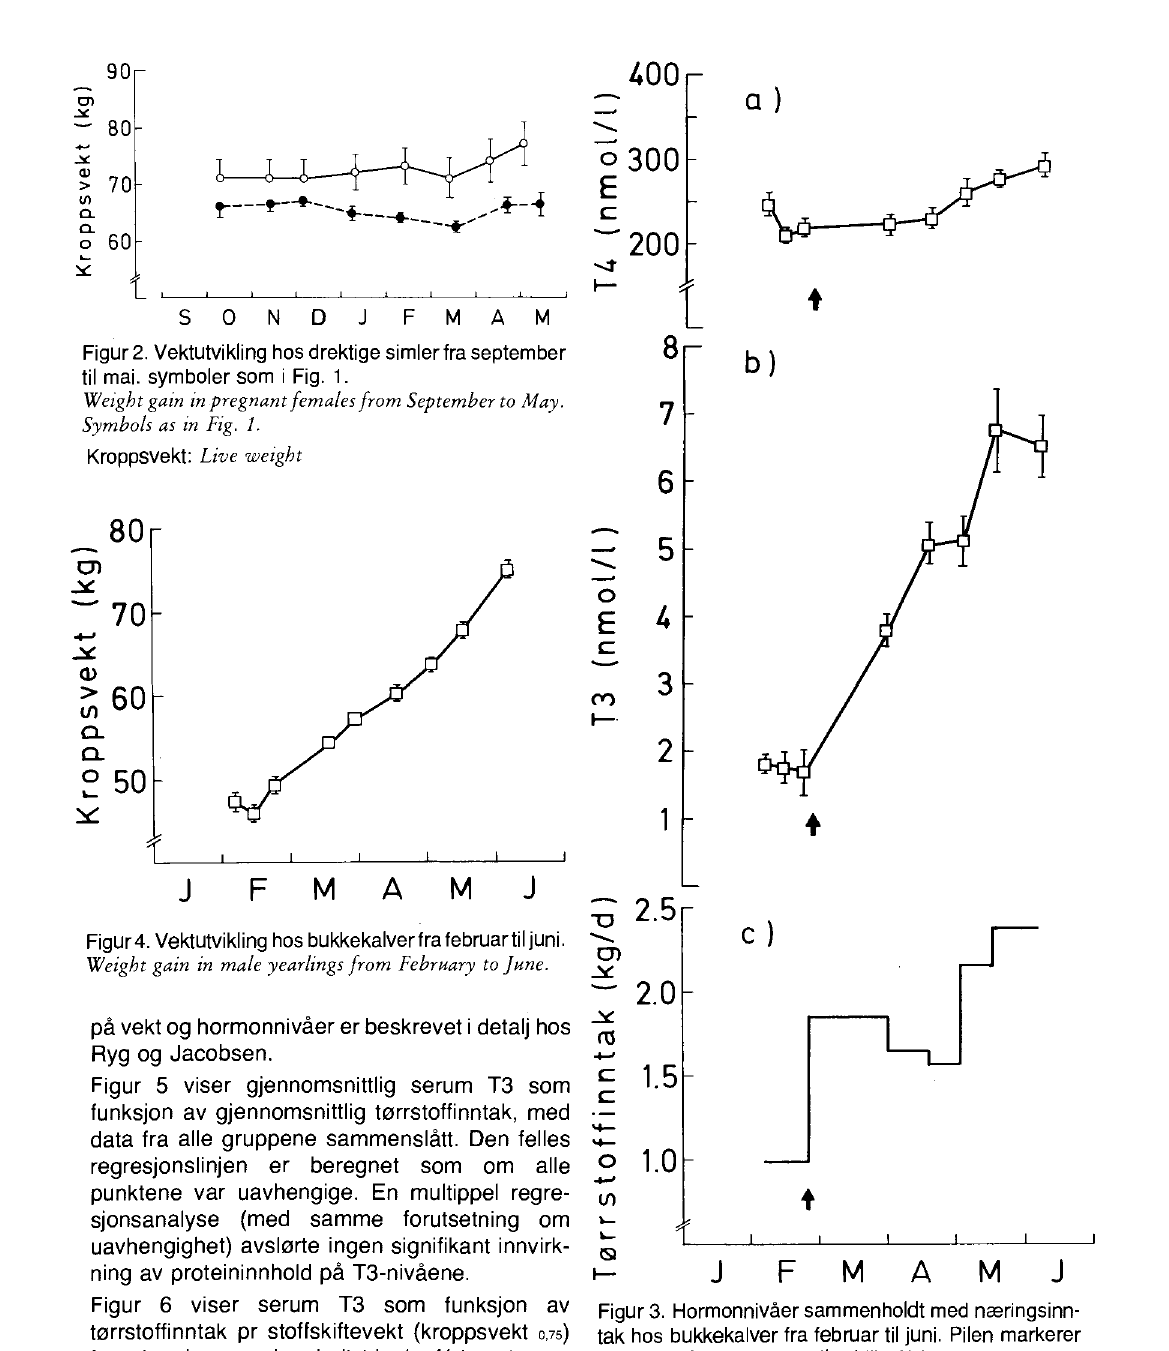
Figur 6 viser serum T3 som funksjon av Figur 3. Hormonnivåer sammenholdt med næringsinn tak hos bukkekalver fra februar til juni. Pilen markerer overgang fra begrenset til ad lib.